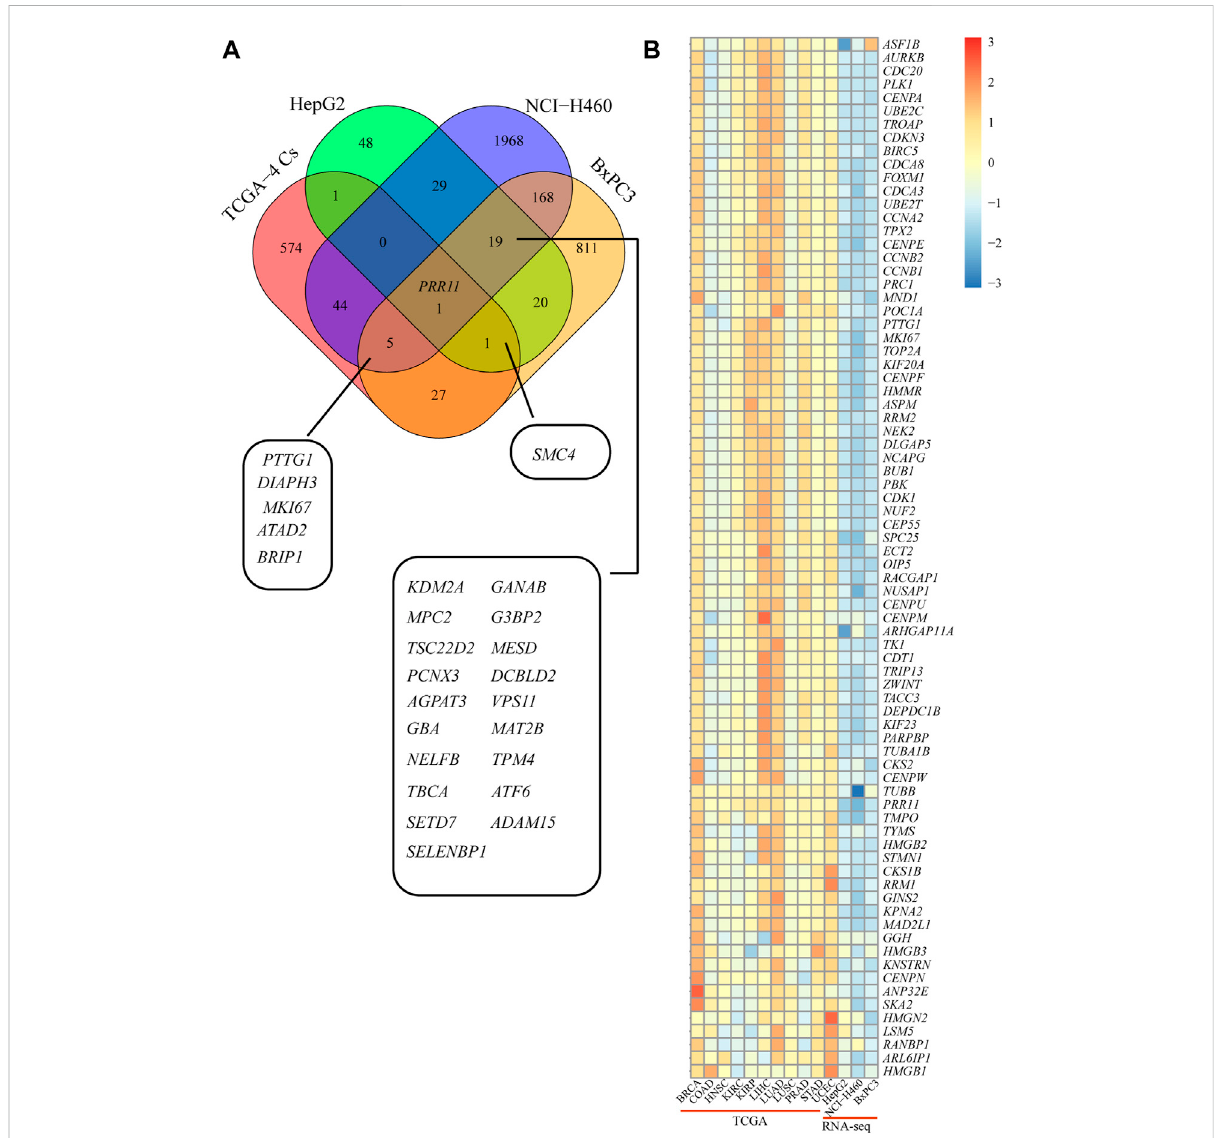
FIGURE 5 PTTG1 mightbeacandidatedownstreamgeneof PRR11 andinvolvedinthecellcycle. (A) OverlapDEGs between TCGA-4Cs andRNA-seq. (B) Heat map of the cell cycle – related genes from both TCGA and RNA-seq. The colors represent the log2FC of different genes from 30% PRR11 high andlowgroupinBRCA,COAD,HNSC,KIRC,KIRP,LIHC,LUAD,LUSC,PRAD,STAD,andUCECandbetweensiPRR11andsiNCgroupsofHepG2,NCI- H460, and BxPC3 cancer cell